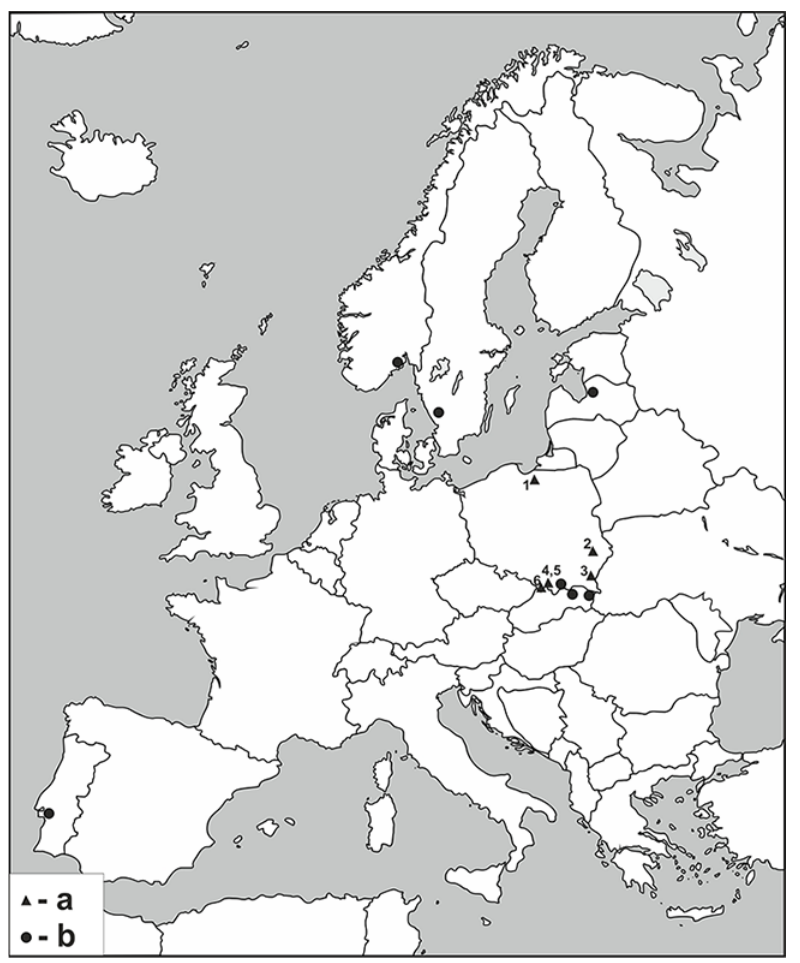
Fig. 1 Localization of Ophiocordyceps stylophora sites in Europe. a – new regions: 1 – Elbląg; 2 – Roztocze National Park; 3 – Przemyskie Foothills Landscape Park; 4 and 5 – Babia Góra National Park; 6 – Oszast Nature Reserve; b – other localities in